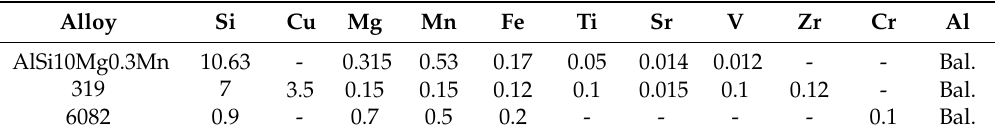
Table 1. Chemical compositions of the studied alloys (wt.%).